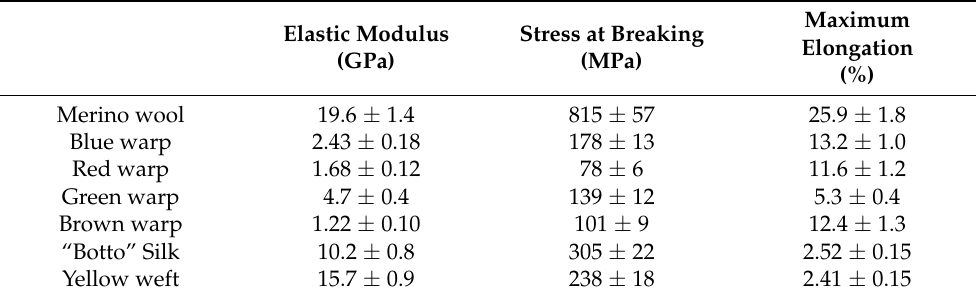
Table 1. Tensile properties at 25 °C of commercial Merino wool, “Botto” silk and the Sixteenth “Botto” Silk Century yarns.